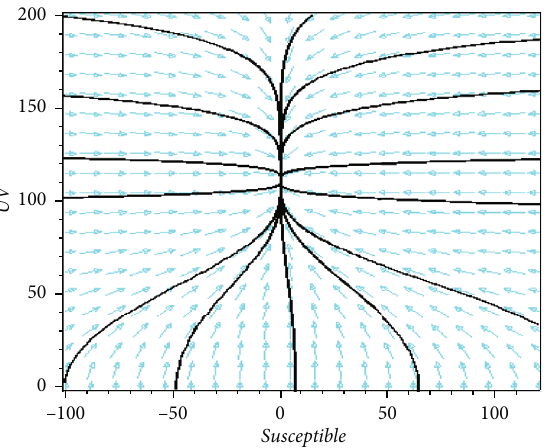
Figure 8: Phase portrait for equilibrium point (0.03,111) when R